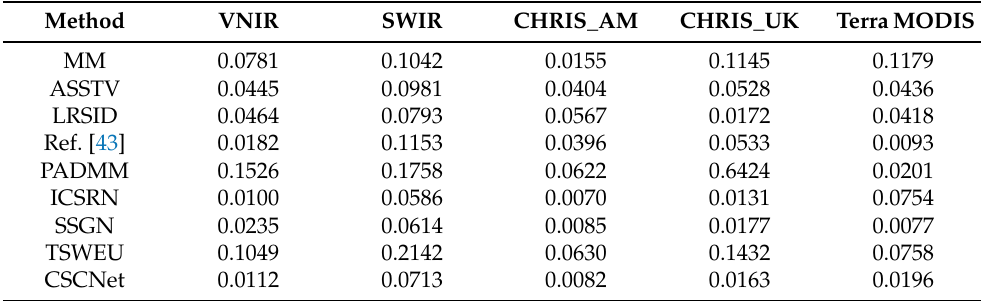
Table 4. MRD of real images’ destriping